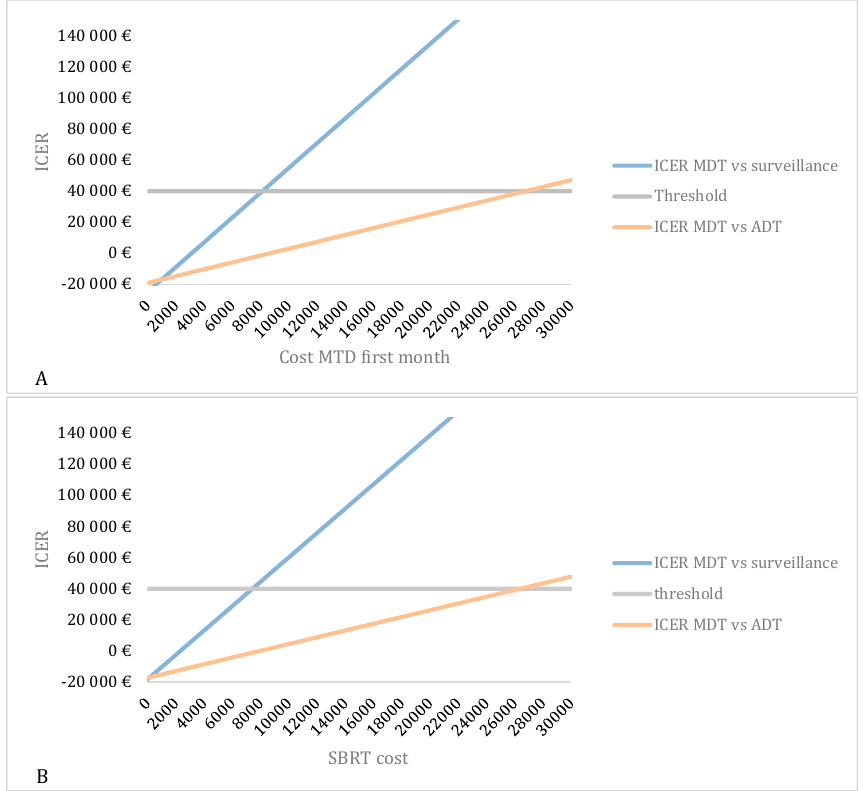
Figure 5. Scenario analyses. ( A ) Overall overview of the cost-utility of MDT versus surveillance or MDT versus ADT in function of the cost of MDT during the first month. ( B ) Overall overview of the cost-utility of MDT versus Surveillance or MDT versus ADT in function of the cost of MDT for SBRT. ADT: Androgen-deprivation therapy; ICER: Incremental cost-effectiveness ratio; MDT: Metastasis- directed therapy; SBRT: Stereotactic body radiotherapy. Cancers 2020 , 12 , x